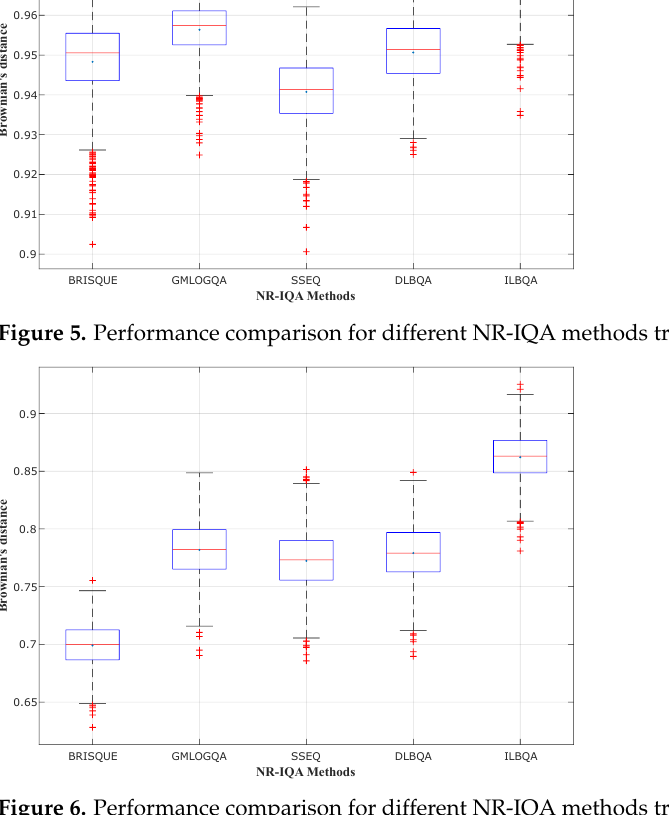
Figure 6. Performance comparison for different NR-IQA methods trained on LIVE Challenge.